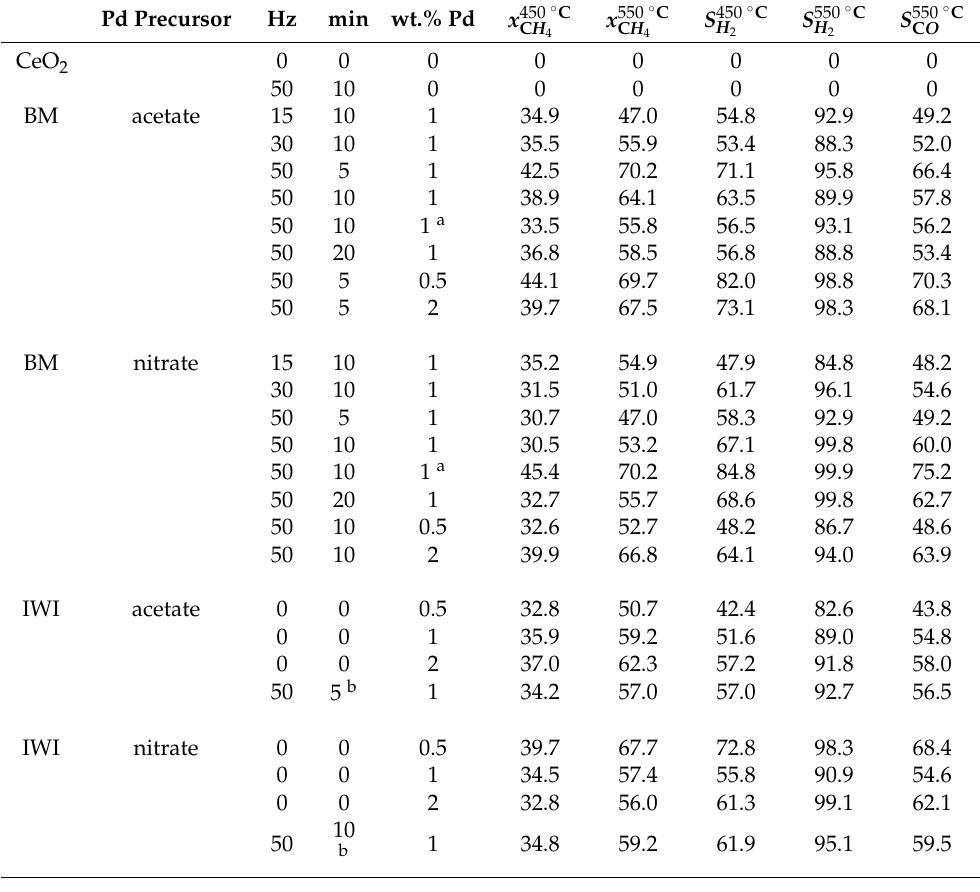
Table 1. Methane conversion and selectivity of hydrogen and carbon monoxide obtained at 450 and 550 ◦ C on bare ceria, ceria after ball milling, and Pd/CeO 2 catalysts prepared by incipient wetness impregnation (IWI) and dry ball milling (BM) using different synthesis parameters and metal loading